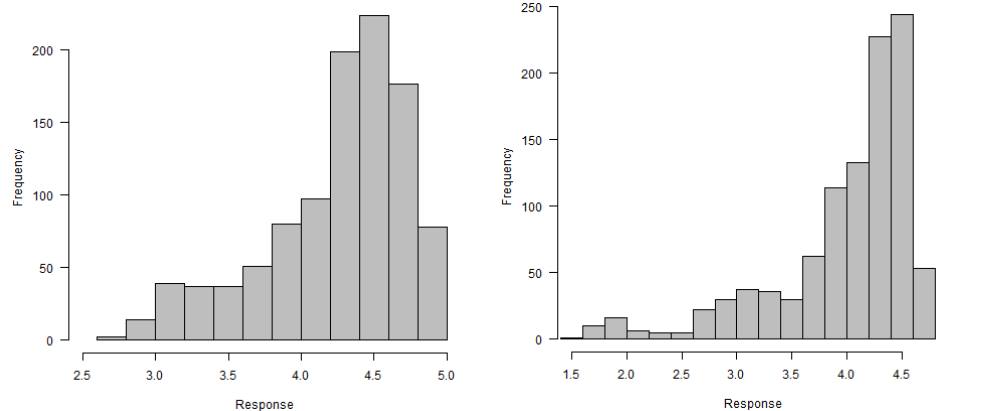
Figure 12. Histograms of gene expressions of PA2975(rluc)(B3) ( left ) and PA0573(E6) ( right ).